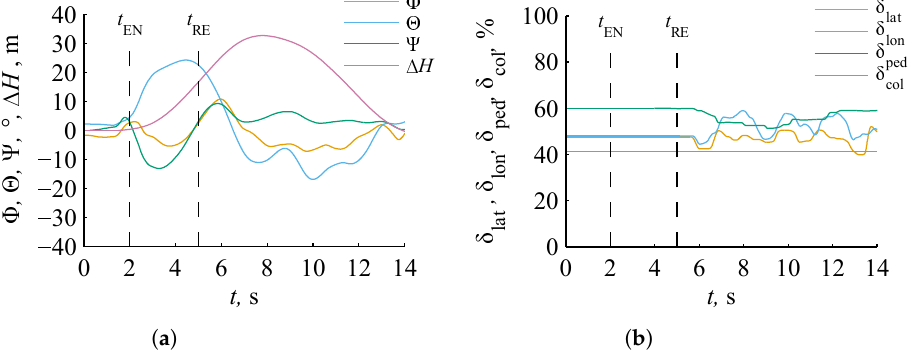
Figure 20. Helicopter reactions and pilot input for the transit task (Pilot A, position 5, V W = 11.3m/s). ( a ) Attitude ( Φ , Θ , Ψ ) and altitude ( ∆ H ). ( b ) Pilot input ( δ lat , δ lon , δ ped , δ col